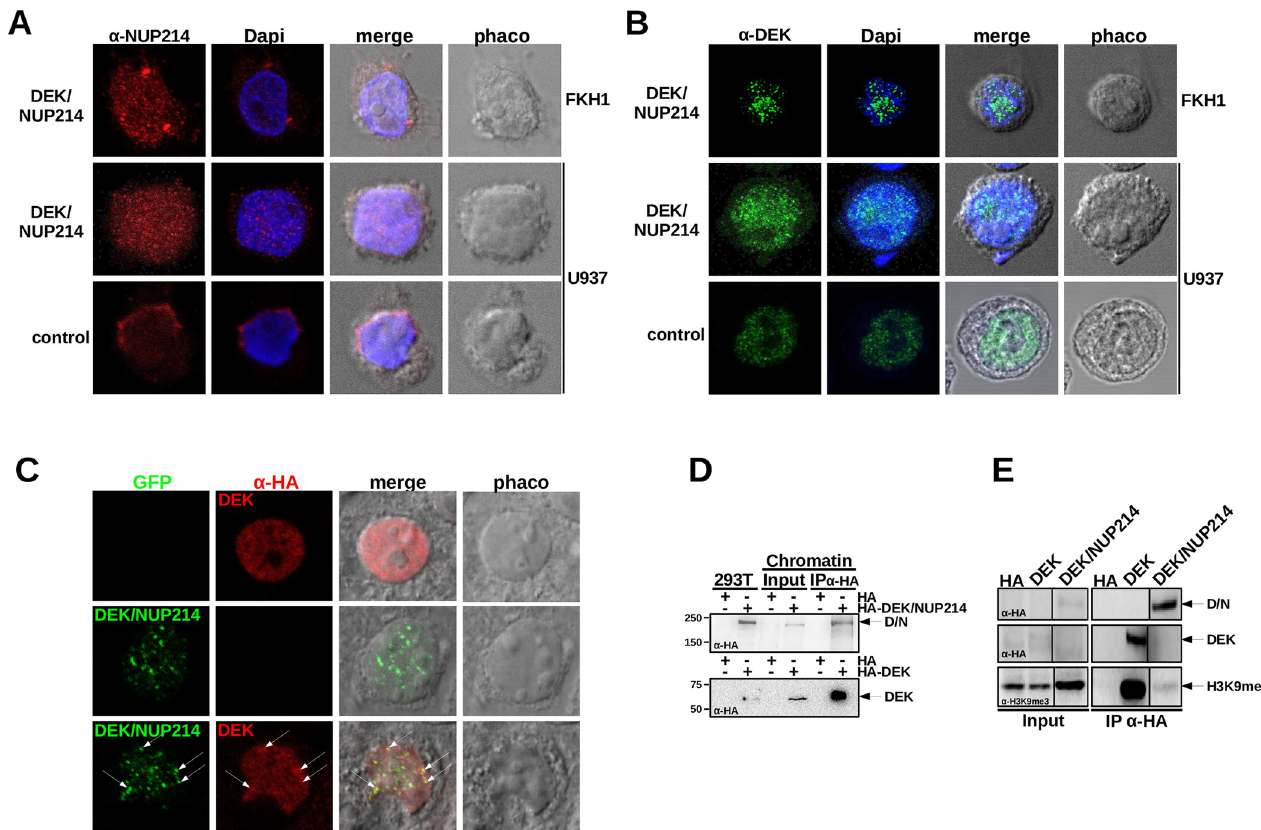
Fig 1. Localization of NUP214, DEK, and DEK/NUP214. A. Localization of NUP214 in t(6;9)-AML cells FKH1 and U937 cells stably expressing DEK/ NUP214 and U937 control cells—CLSM: red fluorochrome–Alexa 594-conjugated secondary Ab detecting the anti-NUP214 Ab; Dapi–Hoechst 3334